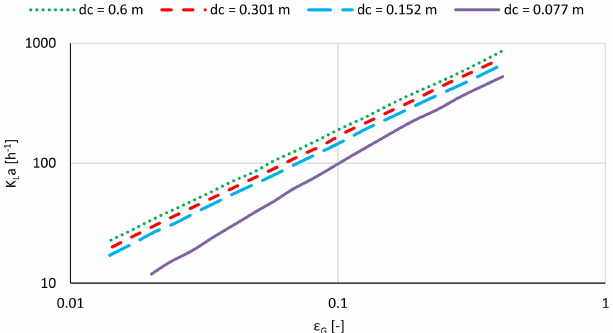
Figure 30. Influence of the bubble column diameter on k L a —data from Akita and Yoshida [47] − 0.15 M Na 2 SO 3 —AIR 20 ◦ C.